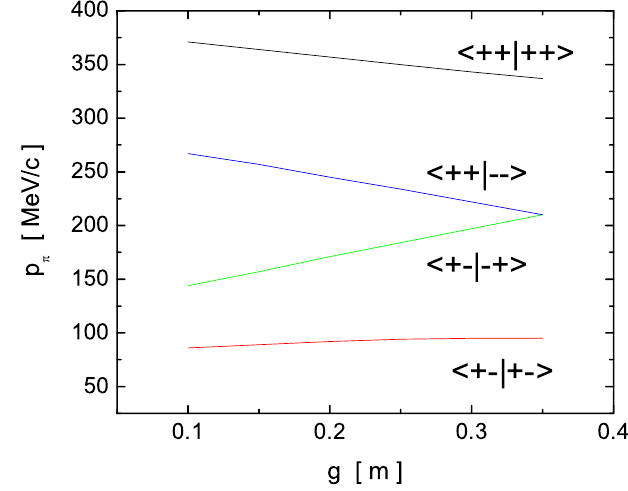
FIG. 13. (Color) Location of (cid:8) resonance as a function of g . The other parameter values were d (cid:2) 150 cm , L (cid:2) 40 cm , a (cid:2)